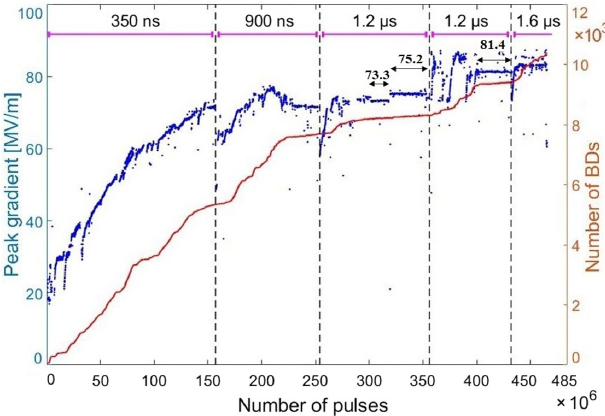
FIG. 8. Conditioning history of the BTWaccelerating structure.